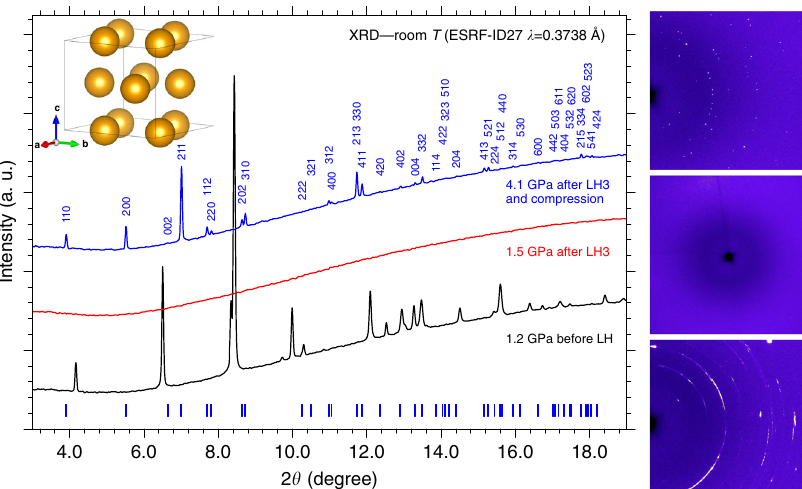
Fig. 2 X-ray diffraction. Integrated panoramic XRD patterns and corresponding detector images of the sample, acquired at room T before laser heating (LH) at 1.2 GPa (black trace, bottom image), after the third laser heating (LH3) at 1.5 GPa (red trace, middle image), and after compression at 4.1 GPa (blue trace, top image). The blue ticks and labels respectively refer to the re fi ned peak positions of the crystalline product at this pressure (Supplementary Note 1) and to the corresponding h,k,l indexing. The tetragonal I 4 cm structure of P atoms as obtained from single-crystal data at 5.5 GPa is also shown in the top left corner of the Figure (see the “ X-Ray Diffraction ”